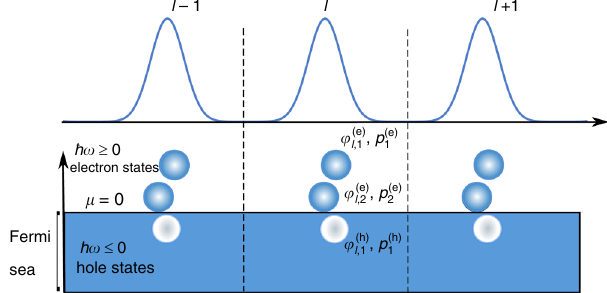
Fig. 1 Sketch of the elementary excitations generated by a periodic current I ( t ). Electron and hole states are generated at each period above and below the Fermi sea. The time-translated wavefunctions φ ð α Þ α = e (electron) or h (hole) and 1 ≤ i ≤ N α are emitted at each period